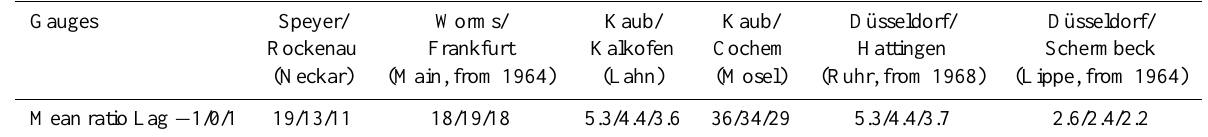
Table 3. “Mean ratio” indicates the long-term mean contribution of the tributary flow in precentage to the Rhine discharge for annual maximum flow events.